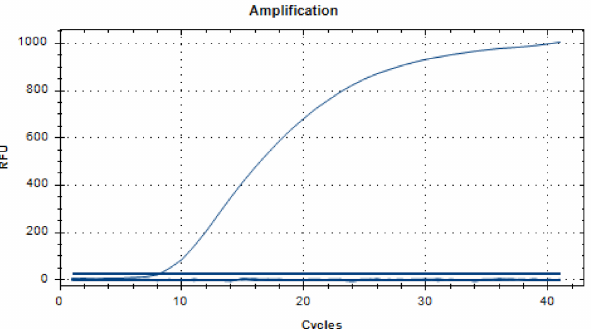
Figure 4. Specificity analysis of the real-time RT-RAA assay. The RT-RAA method specifically detected PEDV nucleic acid, and had no cross-reactivity with porcine parvovirus (PPV), transmissible gastroenteritis virus (TGEV), porcine circovirus type 2 (PCV2), porcine pseudorabies virus (PRV), porcine reproductive and respiratory syndrome virus (PRRSV), classical swine fever virus (CSFV), swine flu virus (SIV), or porcine Japanese encephalitis virus (JEV) nucleic acid. The figure is a representative result of the three independent experiments.